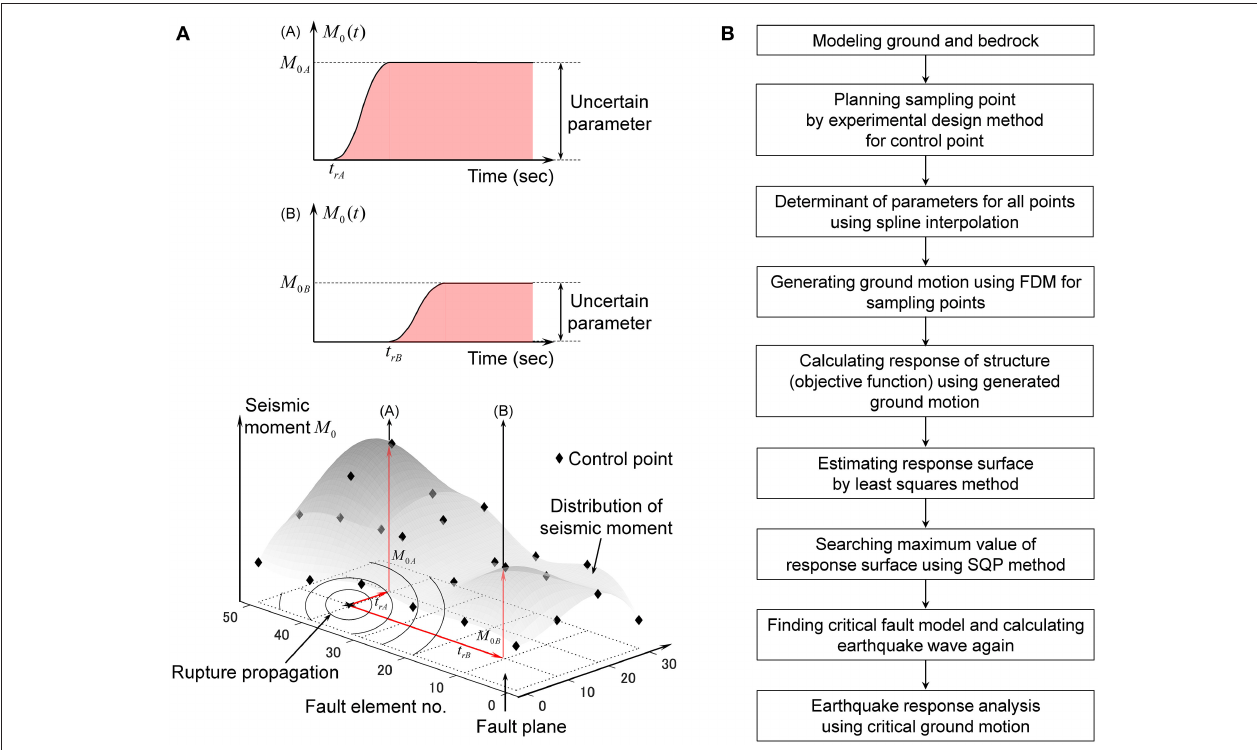
FIGURE 1 | Outline of proposed method. (A) Scheme of setting variable seismic moment distribution in fault. (B) Flowchart for finding critical earthquake ground